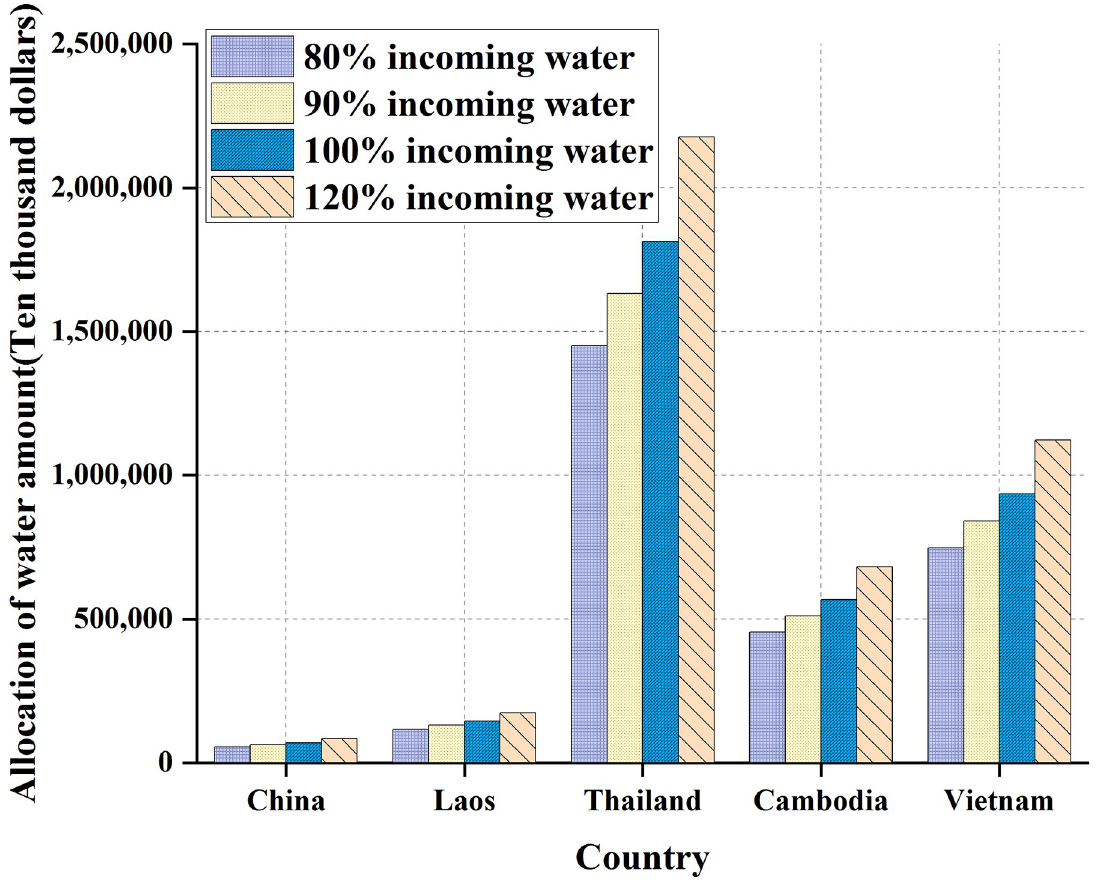
Fig 10. Comparison of grain production benefits under the water resources allocation in five